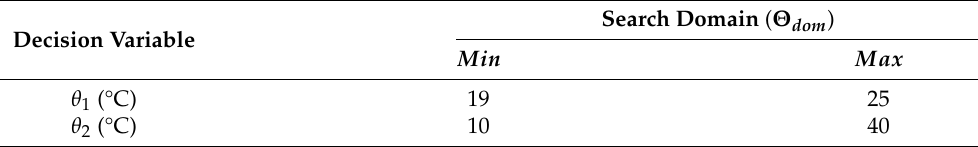
Table 1. Search domain of decision